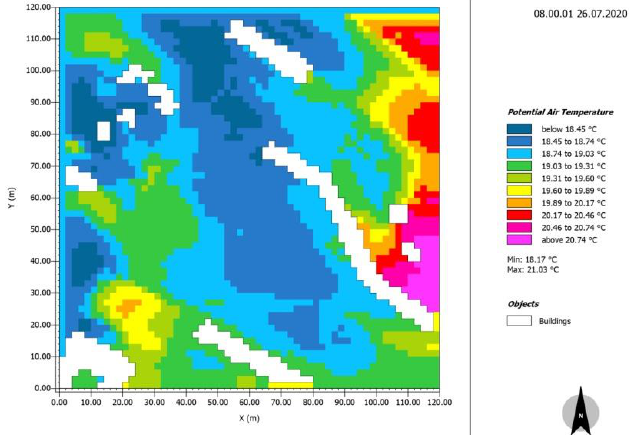
Figure 5. T2 simulation for 8 a.m., 26 July 2020 (image generated by ENVI-met).